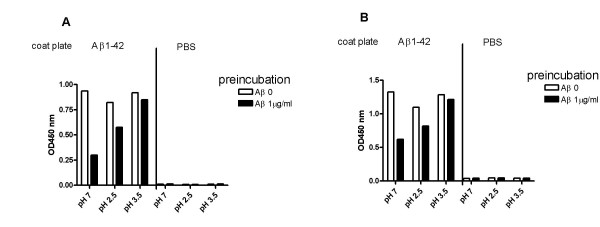
Dissociation of Aβ-IgG immune complexes occurs at both pH 2.5 and pH 3.5. Mouse anti-human Aβ1–16 monoclonal antibody (6E10) at 10 μg/ml (7A) and serum from mice vaccinated with Aβ diluted 1:100 were preincubated with Aβ1–42 peptide at 1 μg/ml to form antigen-antibody complexes (solid bars) or preincubated with PBS as a control (open bars) at 37°C for 60 minutes. Aliquots from each sample were then incubated with a 10-fold larger volume (1:1000 final serum dilution in panel B) of dissociation buffer at pH 7, pH 2.5 and pH 3.5, respectively, for 20 minutes, separated by centrifugation through 10,000 MW filters, neutralized and reconstituted to original volume for standard ELISA assay with full length human Aβ coating the plate.